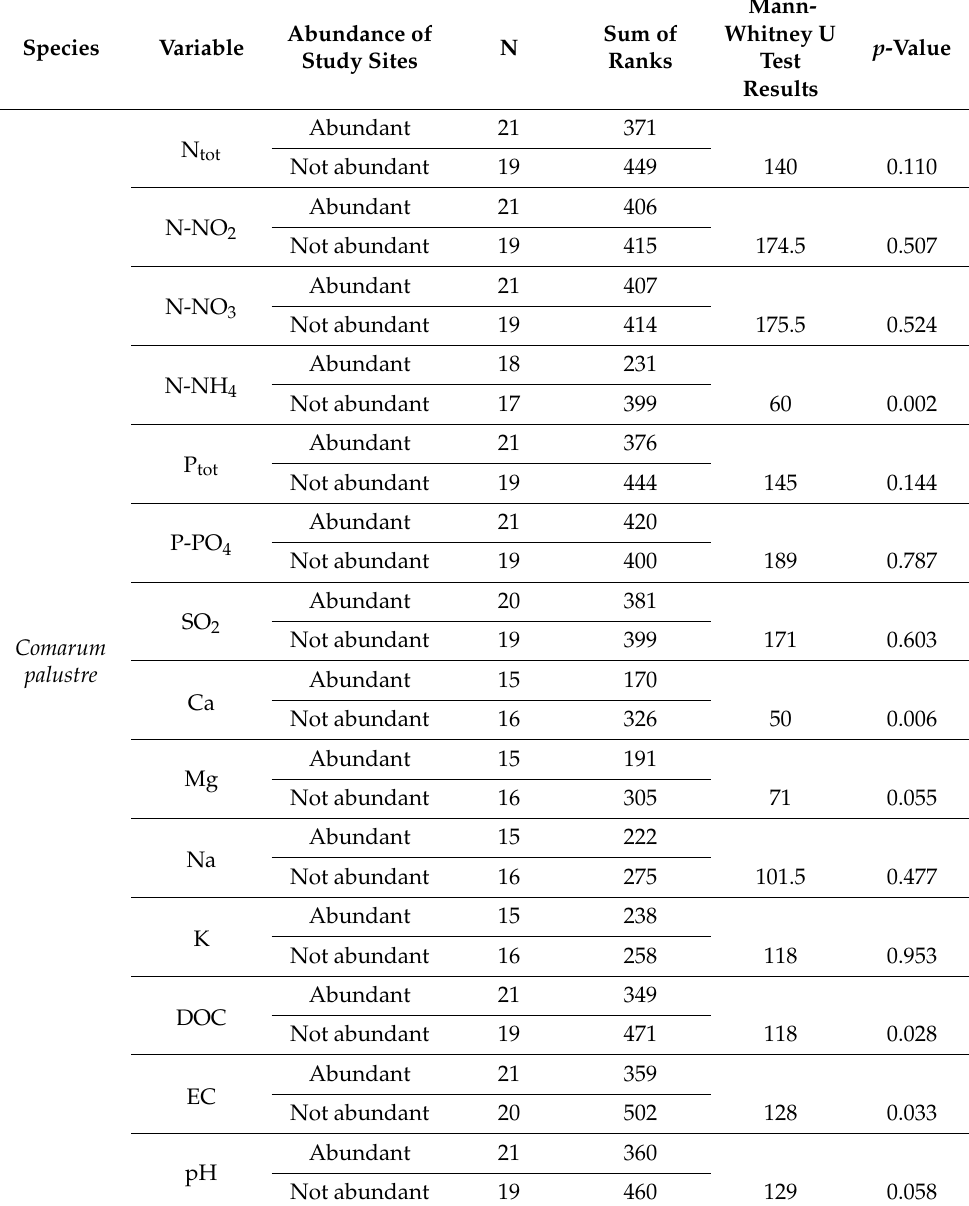
Table 1. Mann–Whitney U test results for comparison of physical-chemical variables at study sites with high and low abundance of the study species.